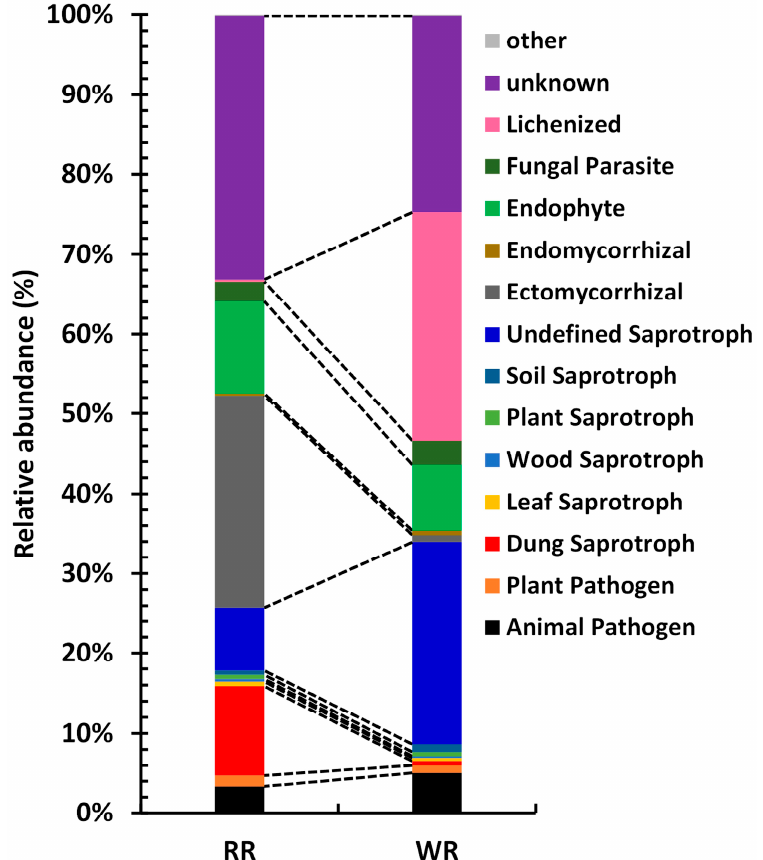
Figure 7. Functions of rhizospheric fungal associated with wild and reintroduced M. sinica (WR1, WR2, and WR3 represent the three replicates of rhizospheric soil samples from wild plants (WR); RR1, RR2, and RR3 represent the three replicates of rhizospheric soil samples from reintroduced plants (RR)) .